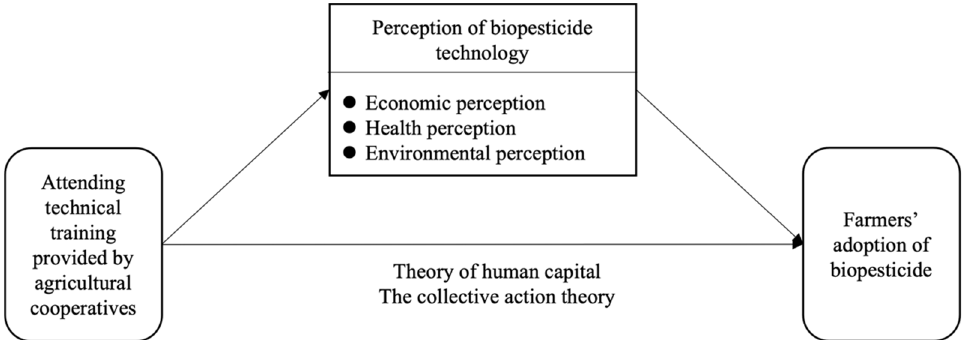
Figure 1. Theoretical model.